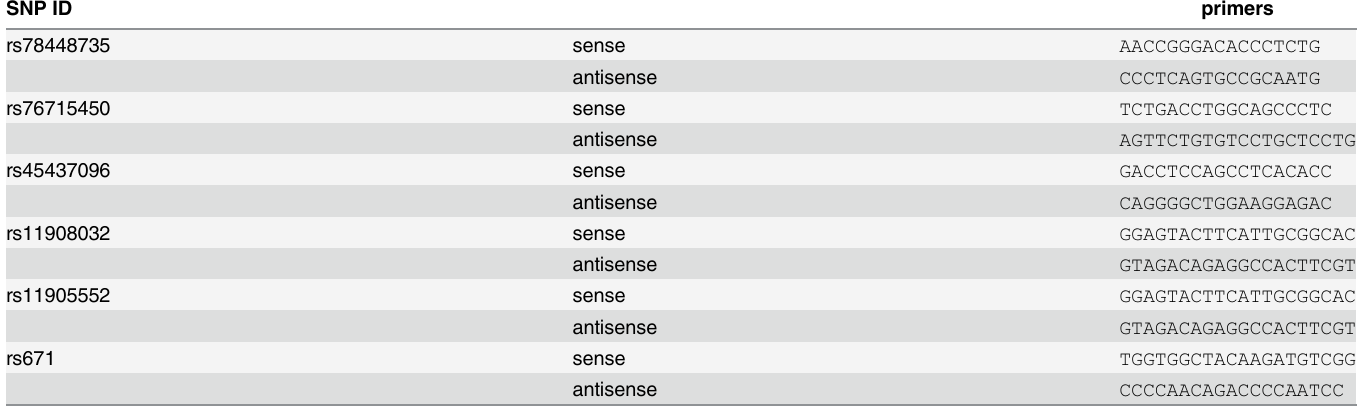
Table 5. Primers sets for